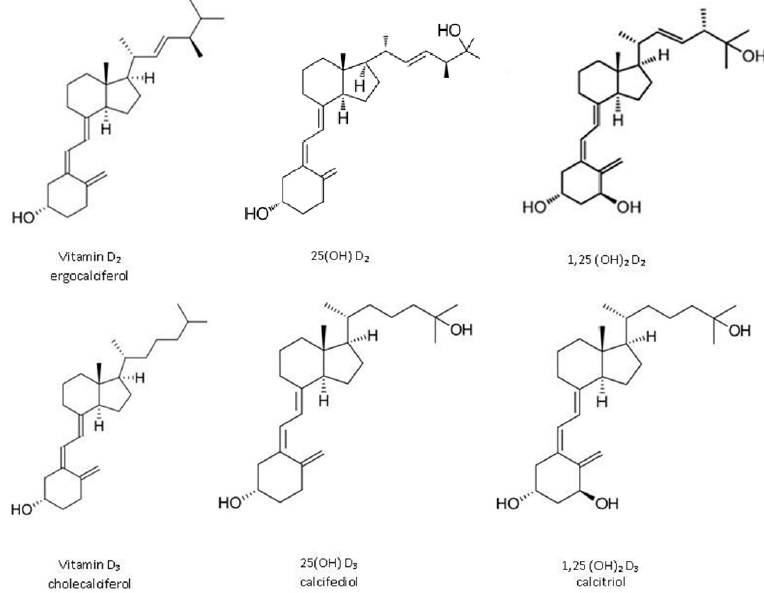
Figure 1. The chemical structure of ergocalciferol, cholecalciferol, and their active derivatives.